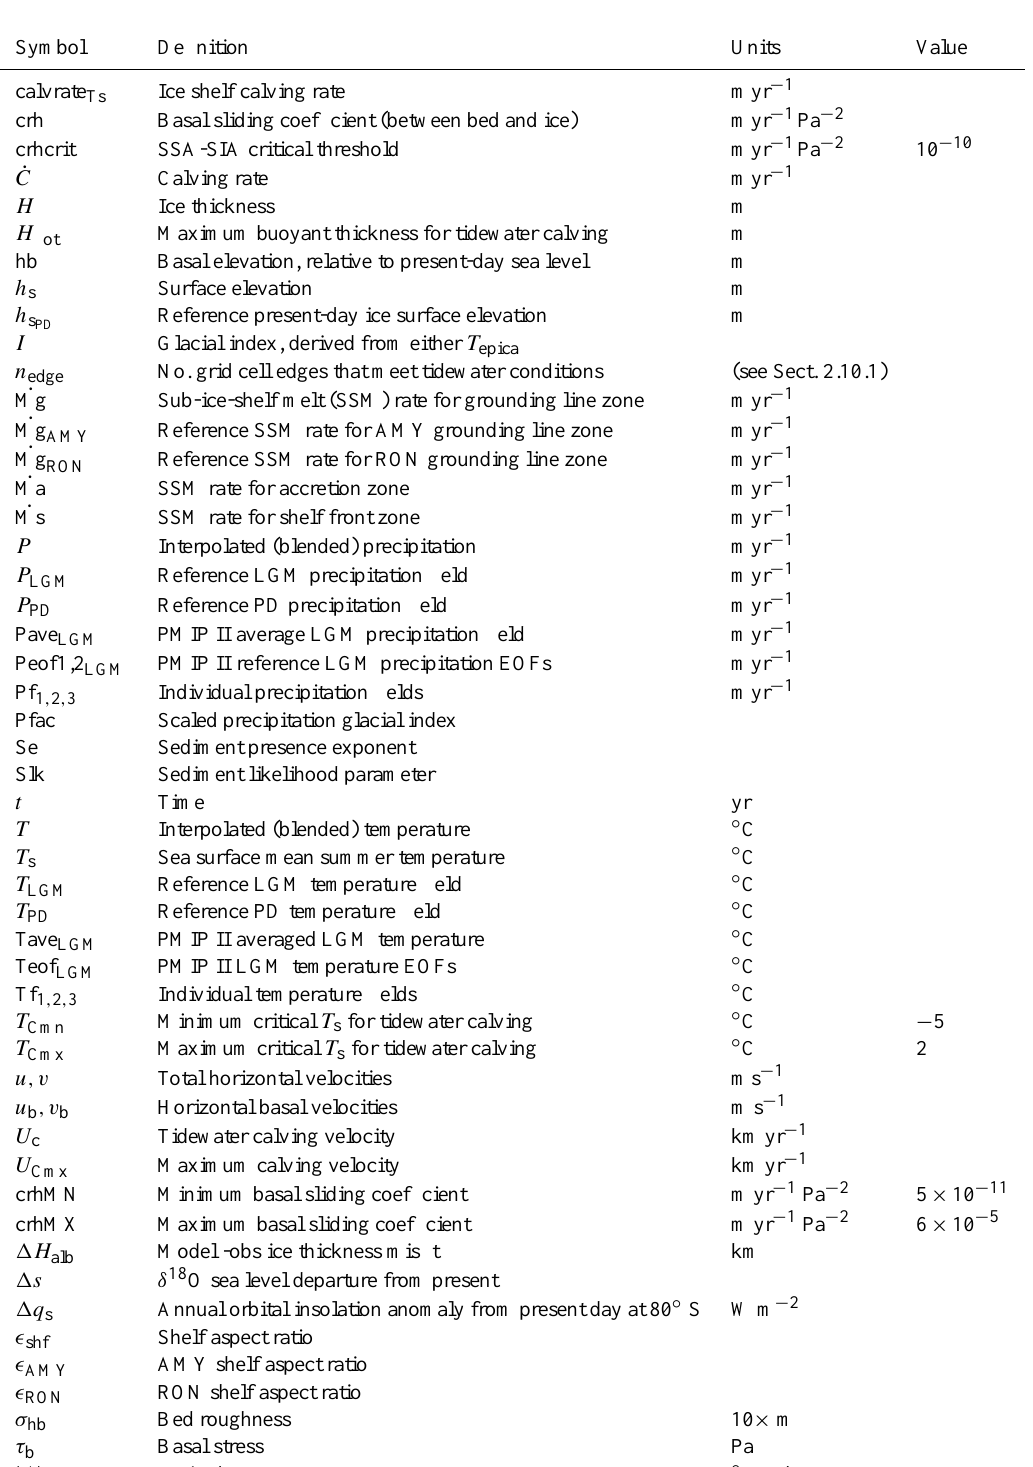
Table 3. Table of symbols and (non-ensemble) model parameters discussed in the text.